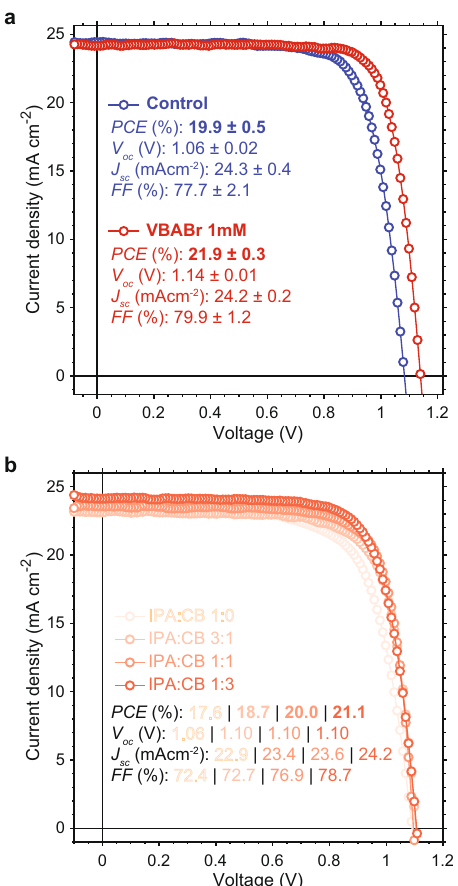
Fig. 5 Photovoltaic devices for different 2D/3D formation conditions. a Reverse scan J – V curves and device metrics for photovoltaics with active layers exposed to 1 mM VBABr in 3:97 IPA:CF and a control device that was not exposed to any ligand solution (3D-only), and for b active layers exposed to 5 mg/mL VBABr in different ratios of IPA and CB. Figures of merit shown here are taken from the average of multiple devices (standard deviations are shown alongside values in panel a , and are omitted in panel b for clarity. A boxplot of values measured for multiple devices and tabulated average values with standard deviations are given in Supplementary Fig. 6 and Supplementary Table 1). Forward scans were omitted here for clarity. See Supplementary Fig. 7 for forward and reverse scan J – V